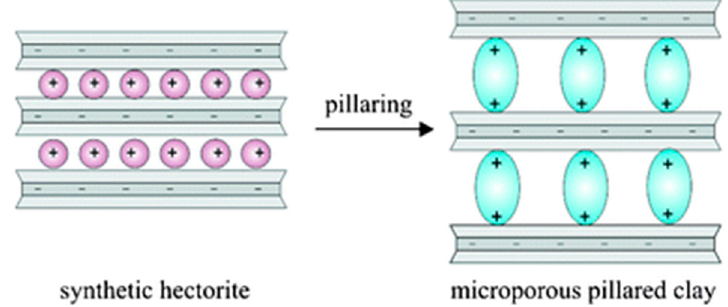
Figure 1. Pillaring, exchange of simple cations for polyoxo cations, e.g., Al-Fe polycation (Al 13- x /Fe x ) 7+ , see Muñoz et al. [30]. Reproduced with permission from Stöcker et al., realization of truly microporous pillared clays, published by Chemical Communications, 2018